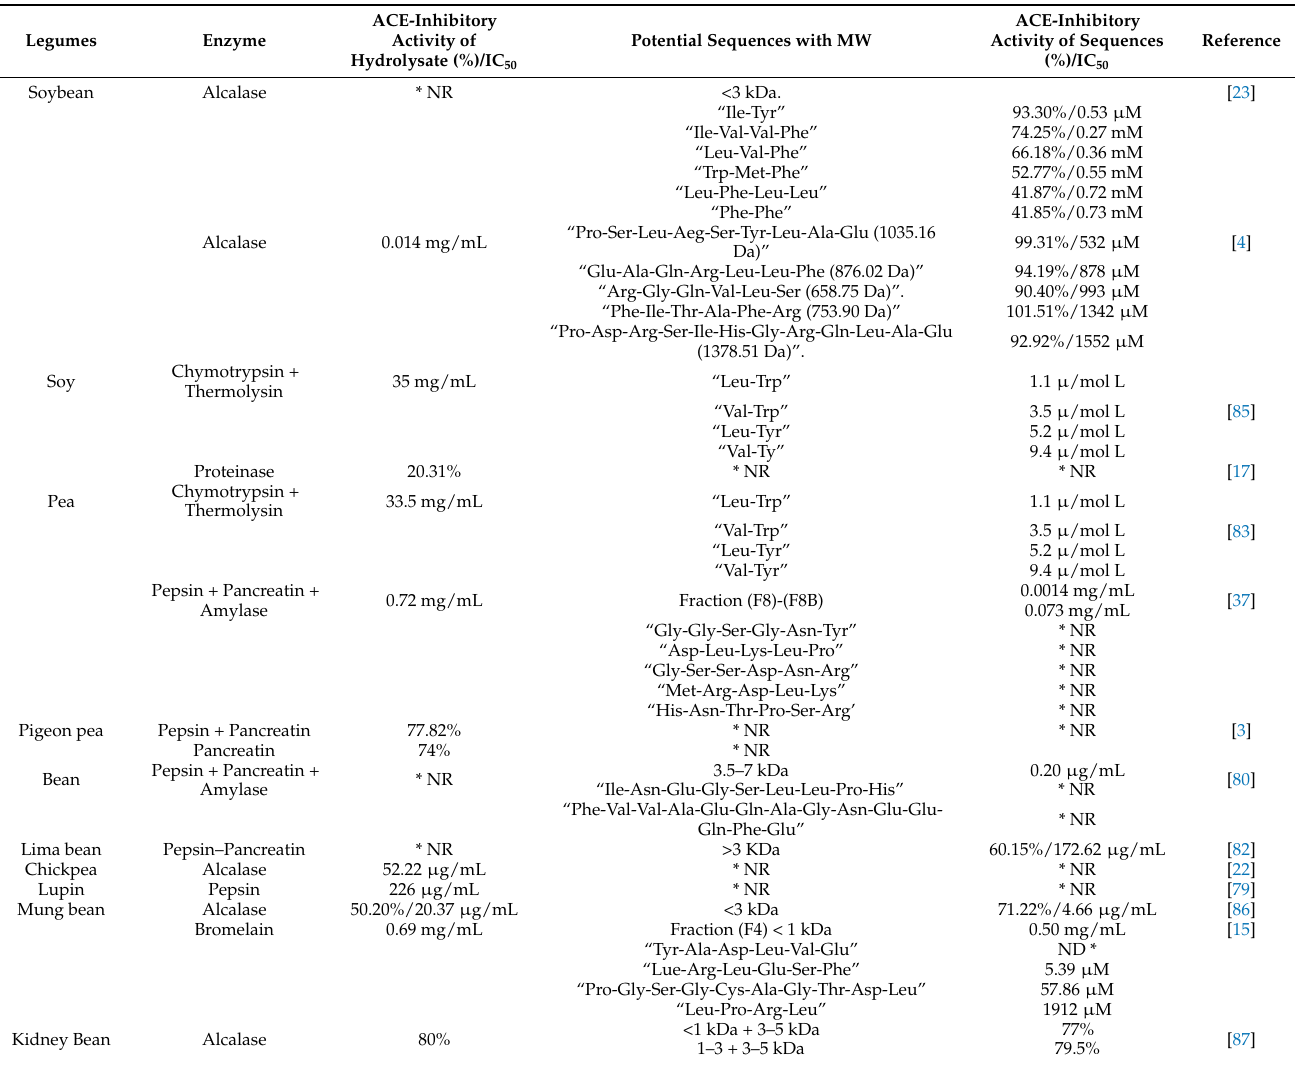
Table 2. In vitro inhibition of ACE of legume protein hydrolysates and